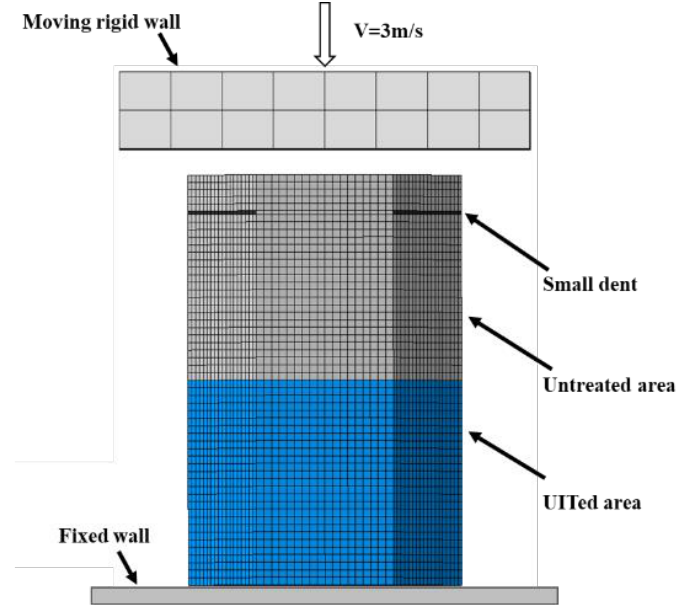
Figure 8. The finite element model.